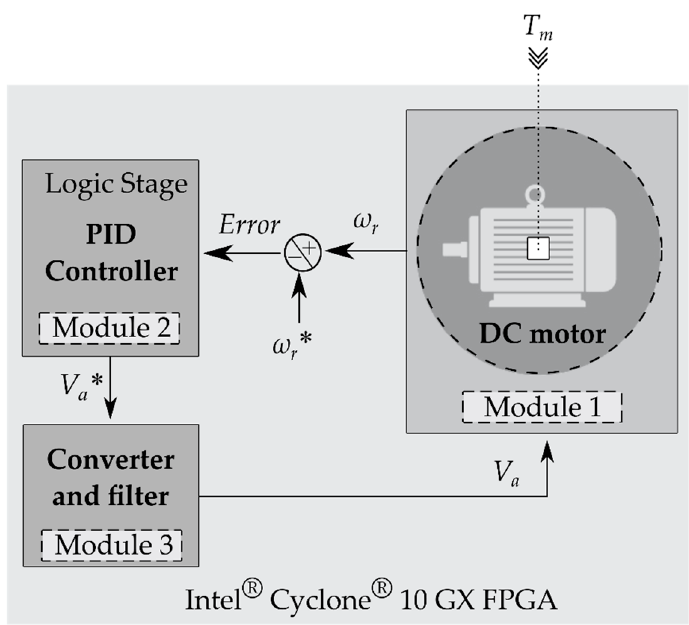
Figure 7. Design flow.